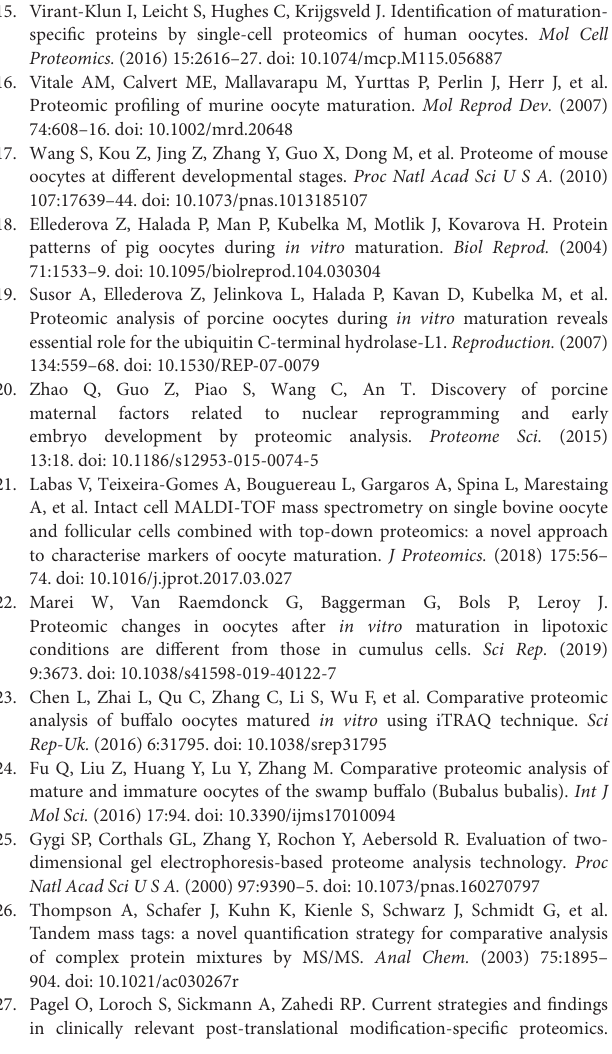
Supplementary Figure S1 | A principal component analysis of all quantified proteins. Supplementary Figure S2 | The fragment ion peak area distribution of identified peptides. Supplementary Table S1 | Annotation of quantified proteins. Supplementary Table S2 | Differentially expressed proteins. Supplementary Table S3 | GO classification analysis. Supplementary Table S4 | COG/KOG classification analysis. Supplementary Table S5 | GO enrichment analysis. Supplementary Table S6 | KEGG pathway enrichment analysis. Supplementary Table S7 | Cluster analysis of enriched GO